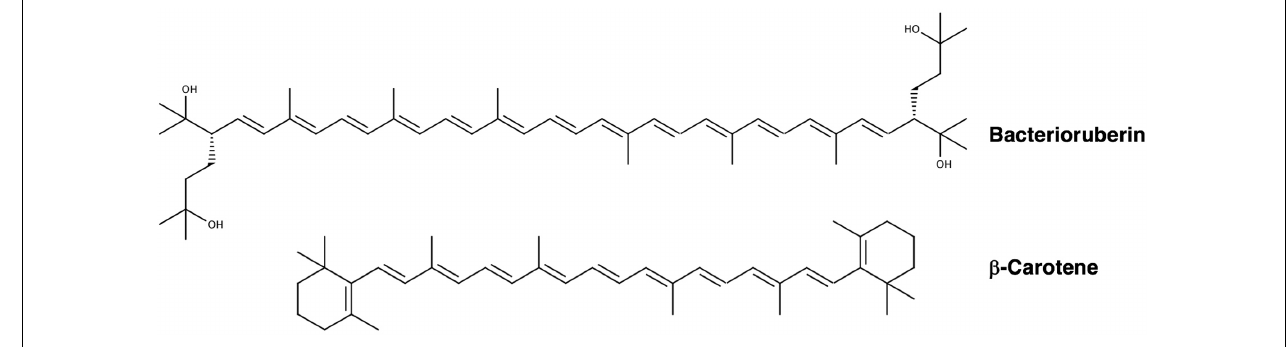
FIGURE 4 | Chemical structures of bacterioruberin and β -carotene (Yang et al., 2015), two major carotenoids produced by halophilic